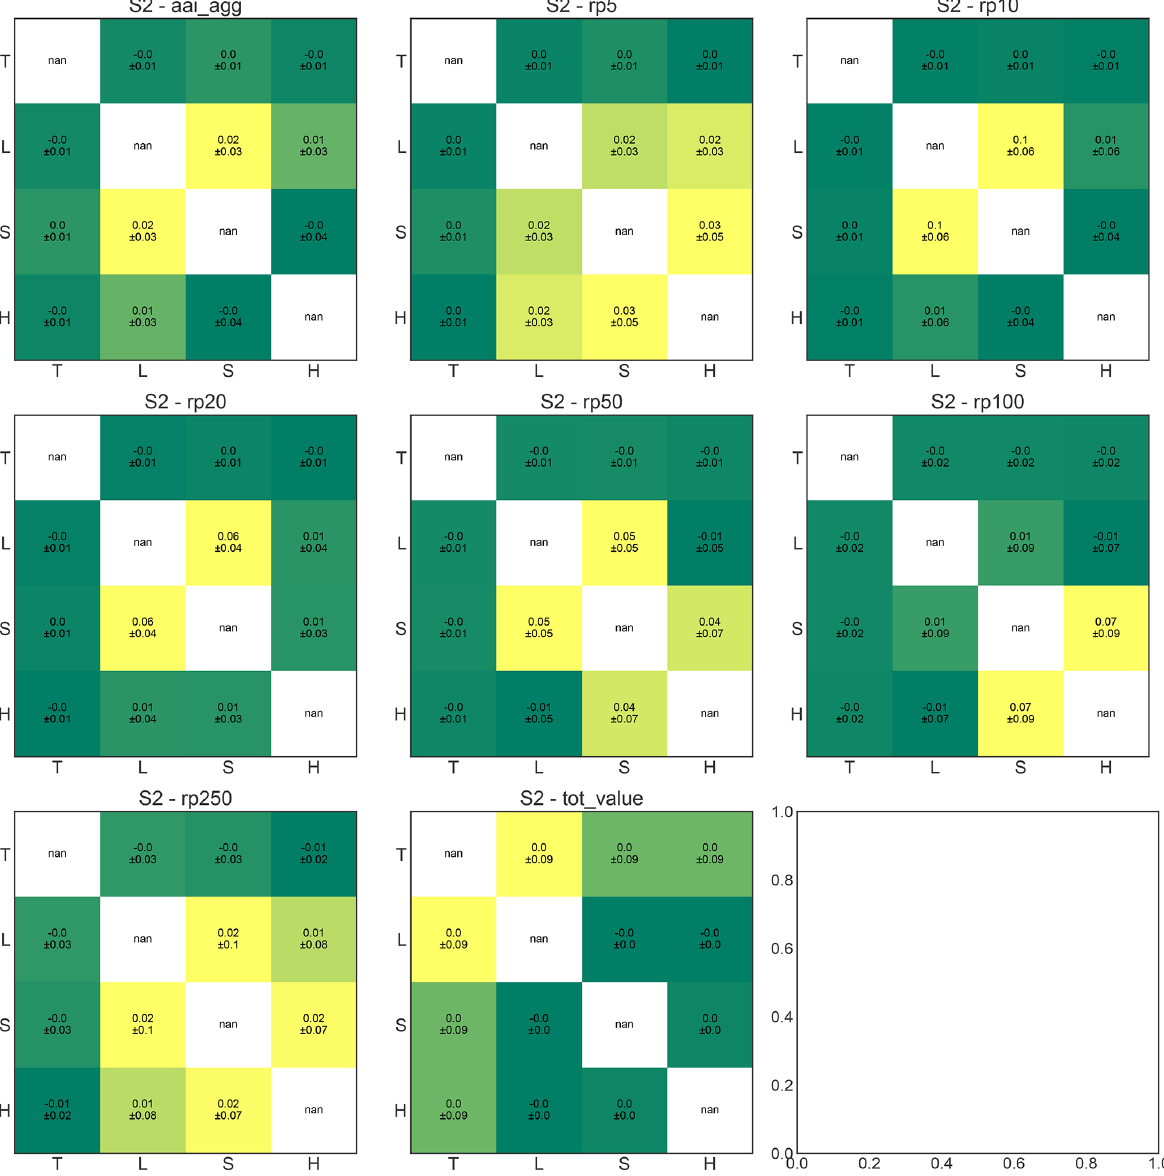
Figure D6. Second-order Sobol (cid:48) sensitivity indices (S2) for different storm surge risk metrics: average annual impact aggregated over all exposure points (aai_agg), impact for return periods (rp) 5 , 10 , 20 , 50 , 100 , 250 years and the total exposure value (tot_value). The input parameters (cf. Table 1) are T : total population, L : population distribution, S : impact function intensity threshold shift, and H : hazard events